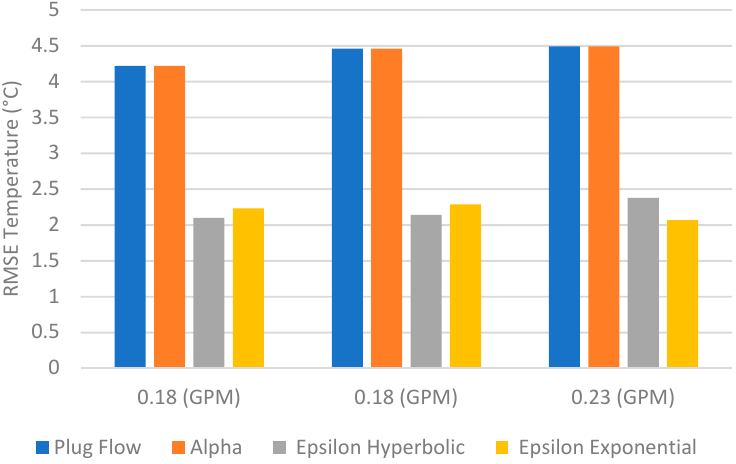
Figure 9. Source heating (charging) RMSE temperatures for plug flow, alpha model, CED model with hyperbolic height relationship, and CED (model with exponential decay based on height).